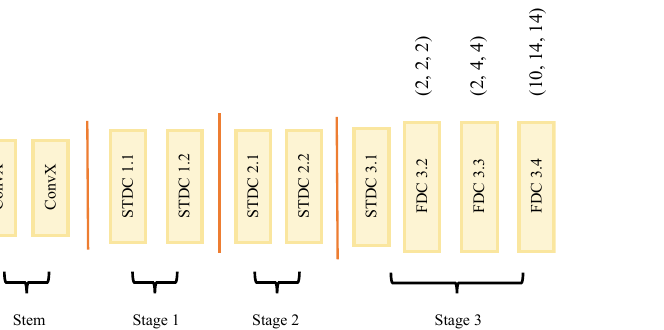
Figure 2. Overview of the network.